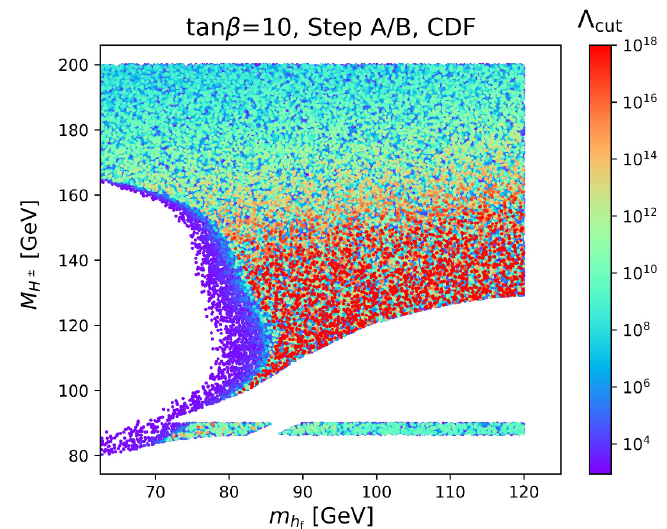
Figure 6 . The parameter points in ( m h the CDF 4 γX measurement [35]. We fix t β = 10 . The color code denotes Λ cut in units of GeV.